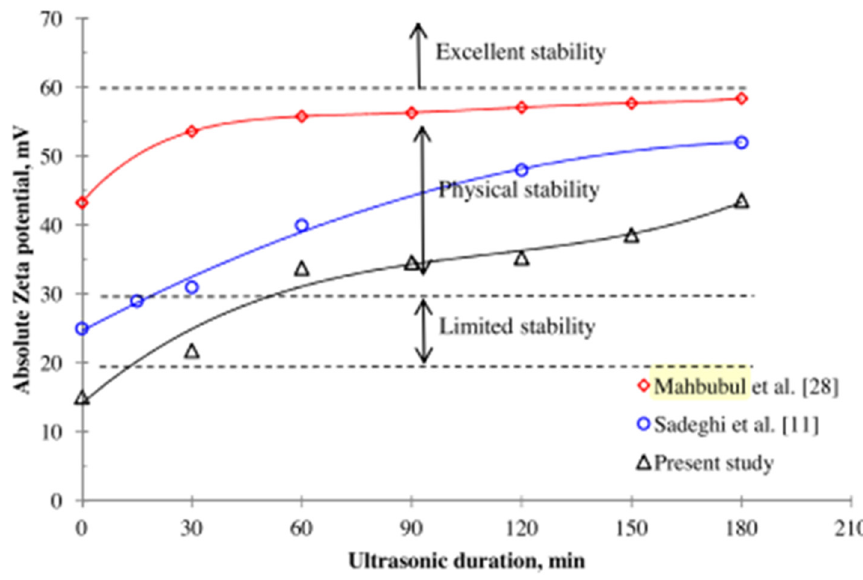
Figure 13. Effect of ultrasonic duration on zeta potentials of TiO 2 —H 2 O NF. Adapted from [124].